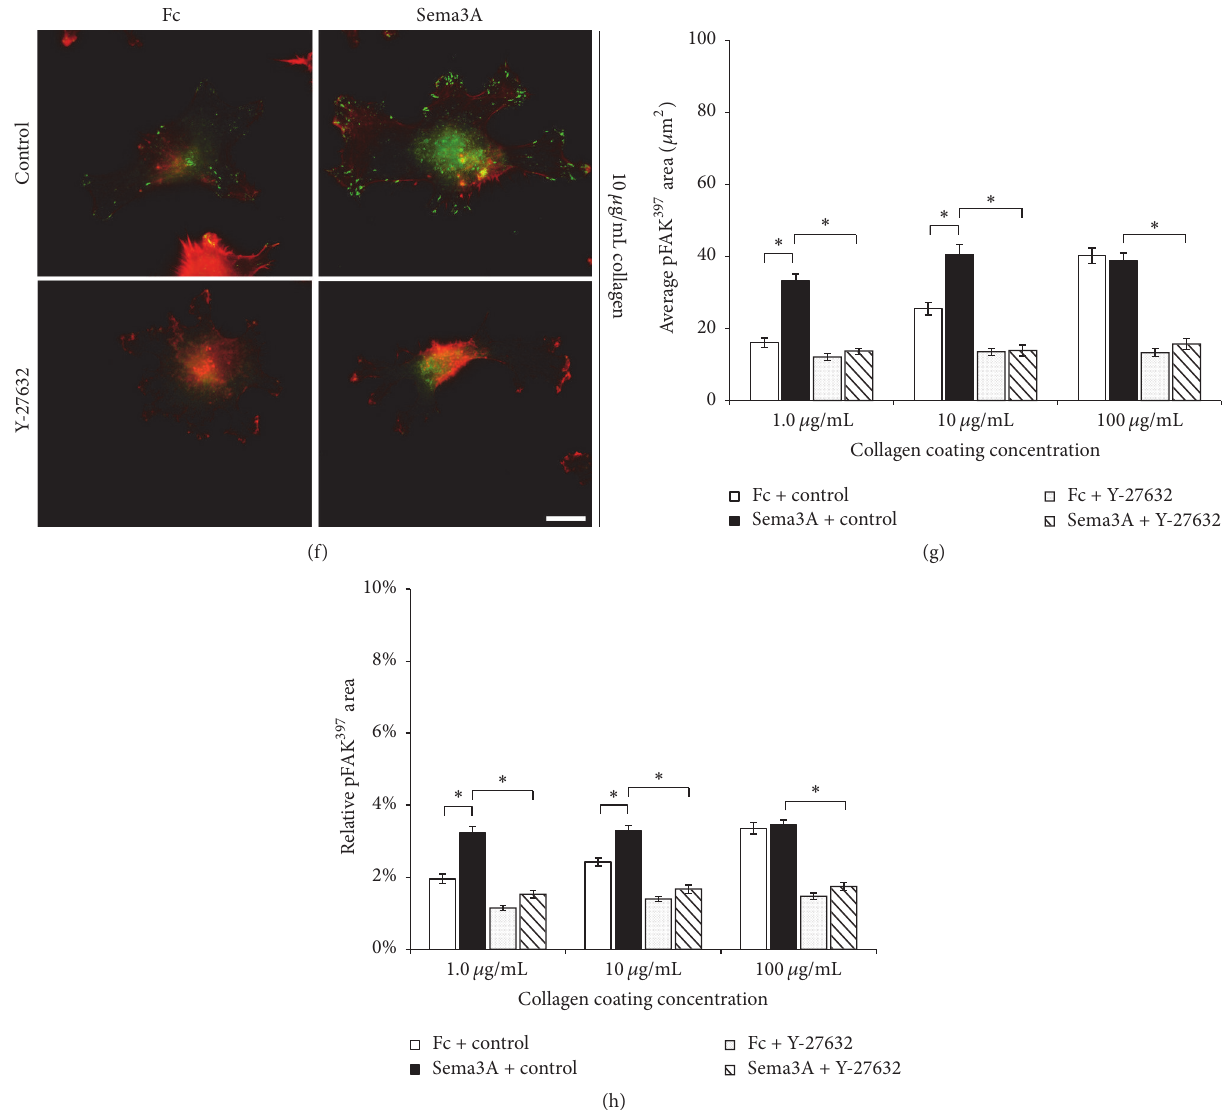
Figure 6: Inhibition of ROCK blocks the Sema3A-mediated effects on cell migration, spreading, and pFAK 397 levels at focal adhesions. (a) Representative phase-contrast images from a scratch assay of cells cultured on substrata coated with 10 𝜇 g/mL collagen in the presence of 100 𝜇 g/mL IgG1 Fc control or Sema3A with and without 10 𝜇 M Y-27632. Scale bar = 100 𝜇 m. (b) Y-27632 blocked the Sema3A-mediated effects on all coating concentrations of collagen as measured using % area closure. Data are presented as average % area closure ± SEM from four independent experiments. (c) Average cell area of cells cultured on substrata coated with low, intermediate, and high concentrations of collagen. Cells were treated with IgG1 Fc control or Sema3A in the absence or presence of Y-27632. Y-27632 blocked the effects of Sema3A on all coating concentrations of collagen. Graphed data represent the mean ± SEM from at least 120 cells for each condition. ((d) and (e)) The effects of Y-27632 on control- and Sema3A-treated cells were assessed using cell circularity (d) and aspect ratio (e). While Sema3A alone decreased circularity and increased aspect ratio on substrata coated with low and intermediate concentrations of collagen, Y-27632 alone produced a similar effect. Data are presented as mean ± SEM from a minimum of 120 cells for each condition. (f) Y-27632 inhibited pFAK 397 staining levels (green) at focal adhesions in both IgG1 Fc control- and Sema3A-treated conditions. Cells were counterstained using TRITC- phalloidin (red). Scale bar = 10 𝜇 m. ((g) and (h)) The average total surface area of pFAK 397 (g) and relative pFAK 397 normalized to total cell area (h) for control- and Sema3A-treated cells exposed to substrata coated with low, intermediate, and high concentrations of collagen in the presence or absence of Y-27632. Graphed data represent the mean ± SEM from at least 50 cells for each condition. ∗ 𝑝 < 0.001 , ∗∗ 𝑝 < 0.005 , and ∗∗∗ 𝑝 < 0.01 indicate statistical significance relative to IgG1 Fc control for all graphed data; two-sample 𝑡